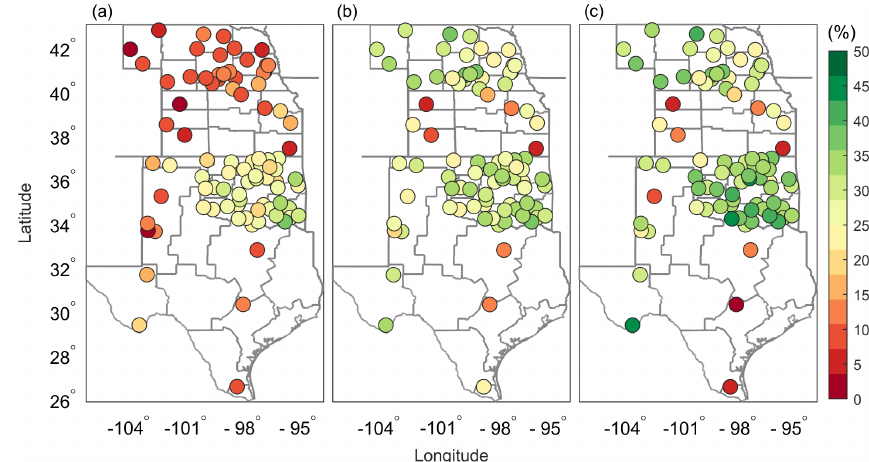
Figure 3. Percentage increments of soil temperature modeling improvement in iEM02, as determined by RMSE changes (cid:20) (cid:21) (cid:0) RMSE (cid:1) improved − RMSE original − 100 (a) after introducing an air temperature of T a ,j − 3 , (b) after substituting the air temperature T a with a RMSE original fictive environmental temperature ( T env ), and (c) after integrating the impacts of soil thermal diffusivity and snow cover. The color bar was coded by the improved percentage of iEM02 against the EM02 model.